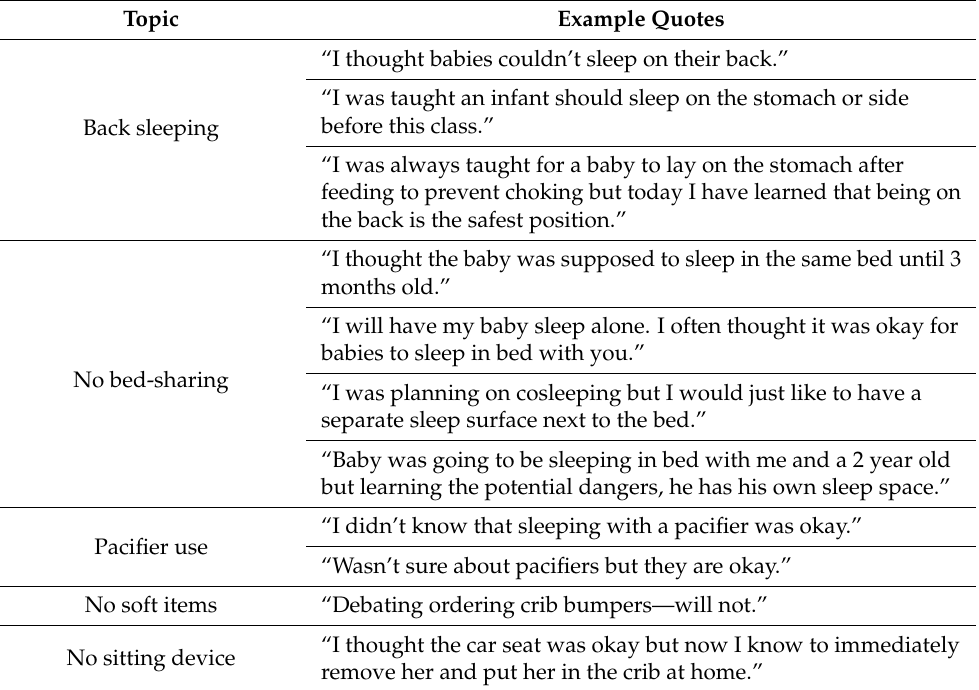
Table 4. Example written comments regarding corrected misinformation from